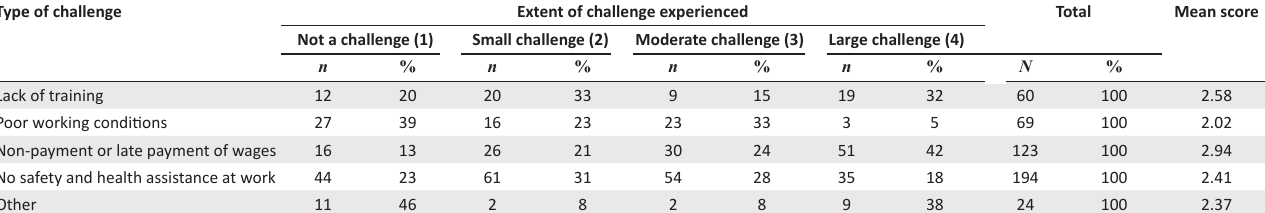
TABLE 6: Challenges experienced by the respondents with the community work programme in Erasmus and Soshanguve. Type of